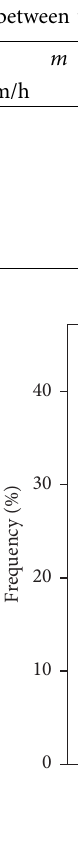
Figure 4: Age distribution of male drivers with DS over 95 km/h. Table 4: Two-sample t -test of driver age between men’s DS